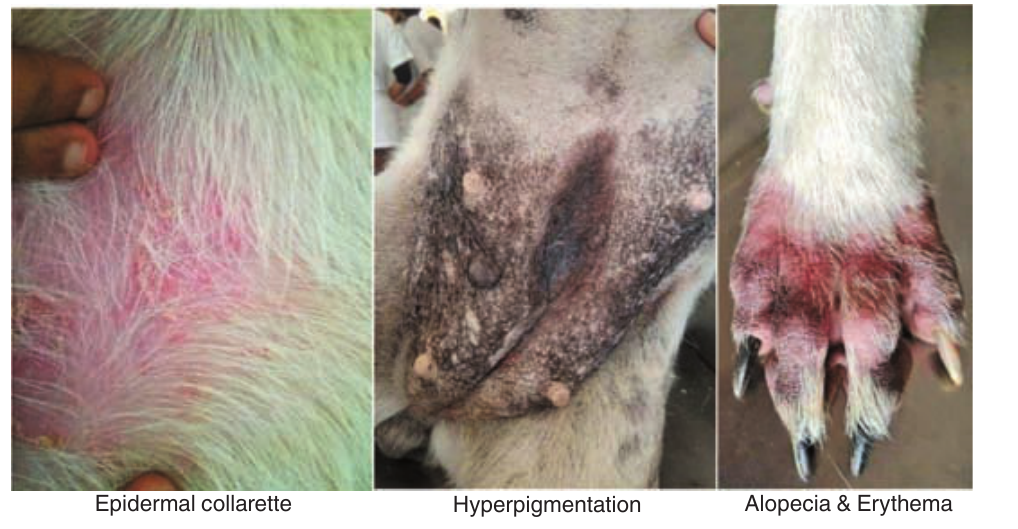
Fig. 1. Clinical manifestations of malasseziosis in